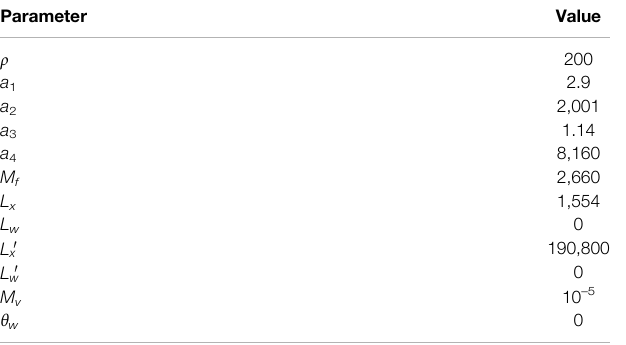
TABLE 7 | Third set of parameters for CSTR model.